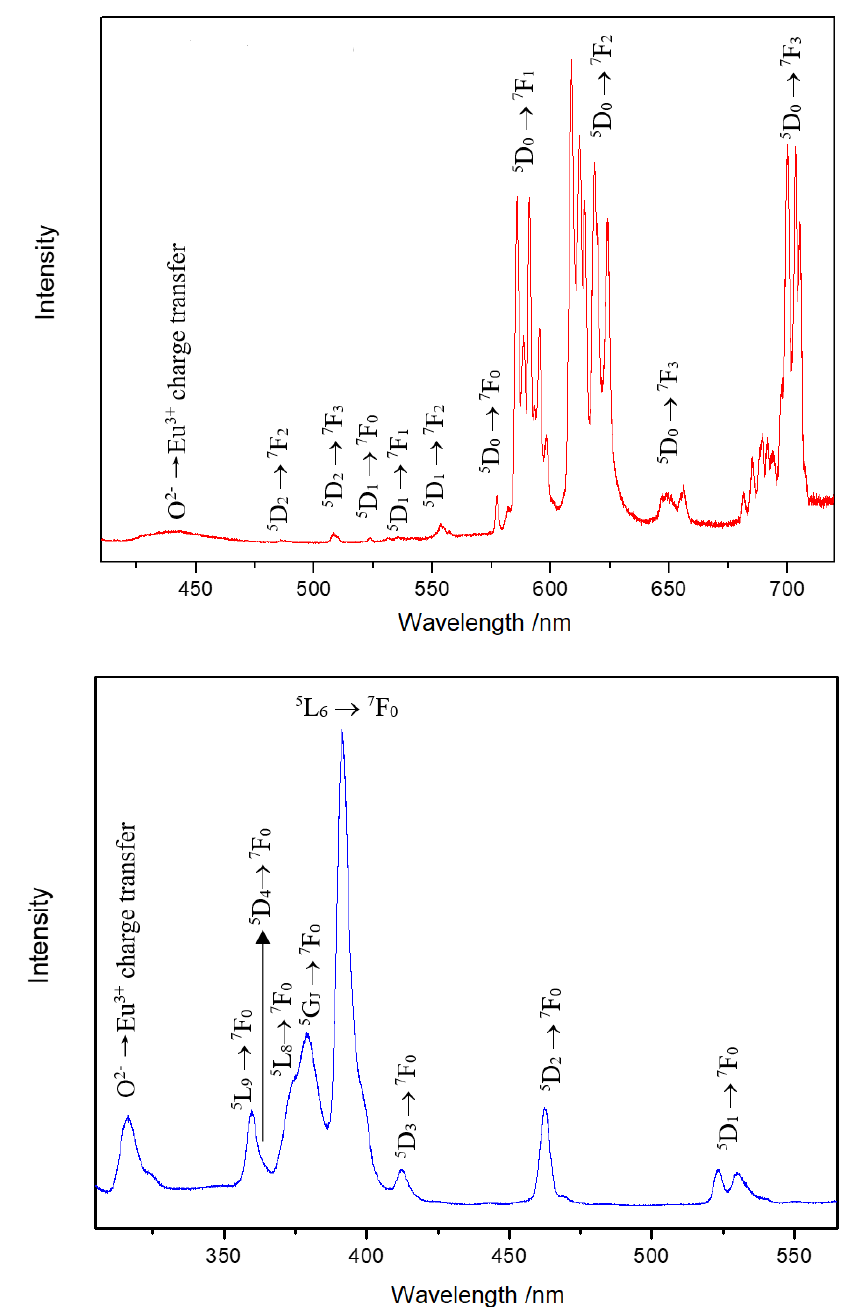
Figure 6. Emission spectrum of Y 3 F[Si 3 O 10 ]:Eu 3+ excited at 390 nm at room temperature ( top ). Excita- tion spectrum of Y 3 F[Si 3 O 10 ]:Eu 3+ detected at the emission energy of 585 nm at room temperature ( bottom